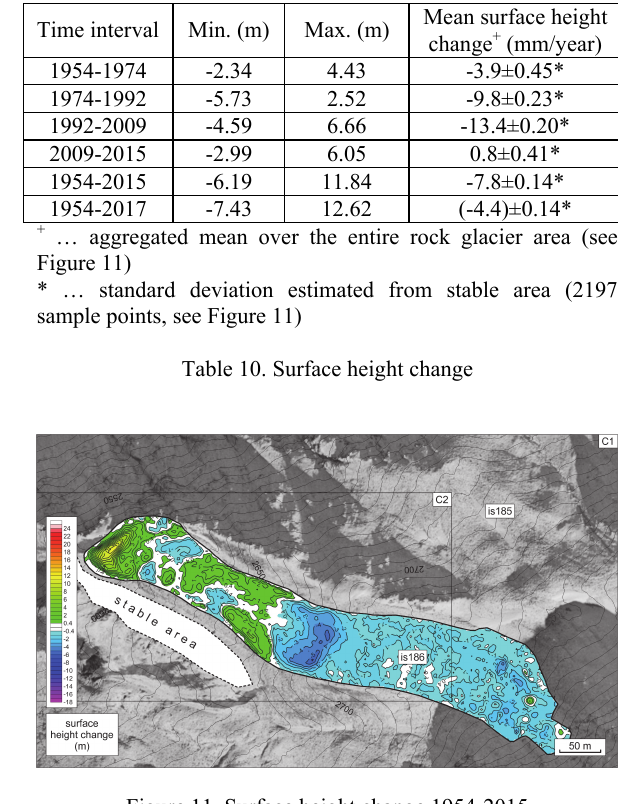
Figure 11. Surface height change 1954-2015